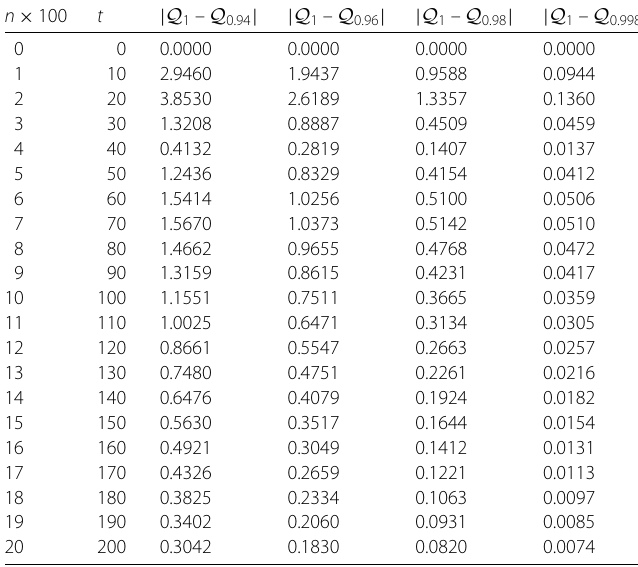
Table 6 The values of | Q 1 – Q φ | for φ = { 0.94,0.96,0.98,0.998